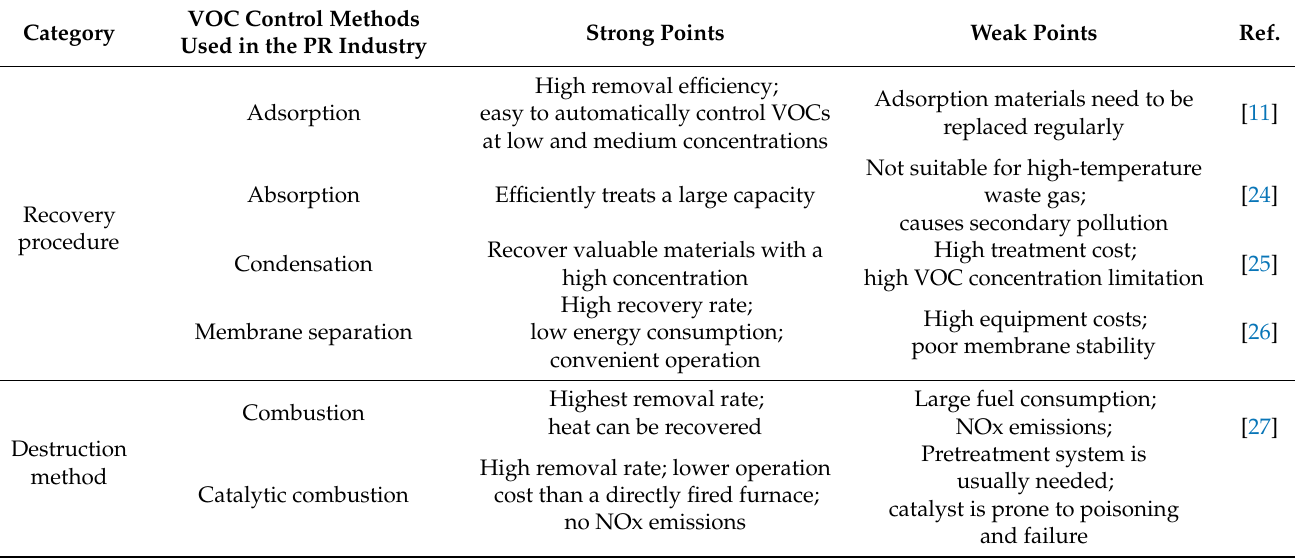
Table 1. Summary of VOC control technologies.